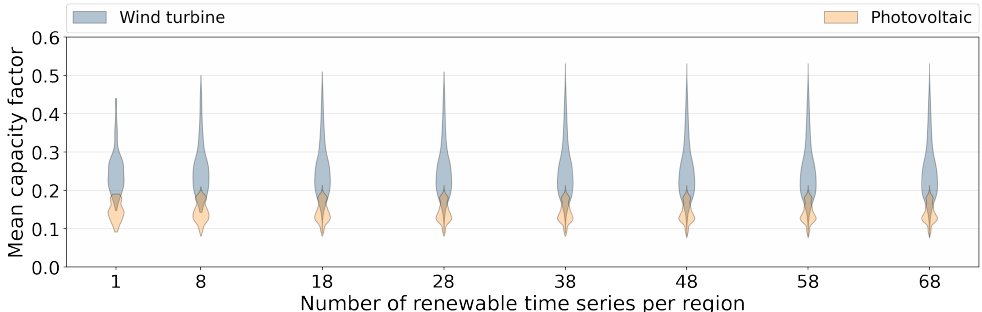
Figure 7. Distribution of installable capacities in all 96 e-highway regions, for different number of VRES time series per region.